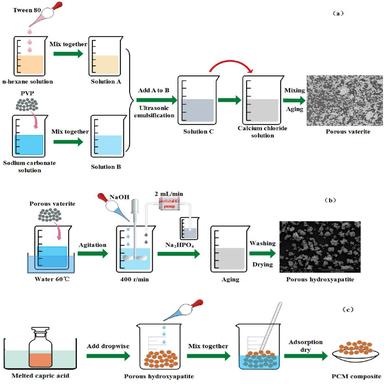
The schematic fabrication of the (a) porous calcium carbonate hollow microspheres, (b) porous HAP, and (c) HAP/CA CPCM.